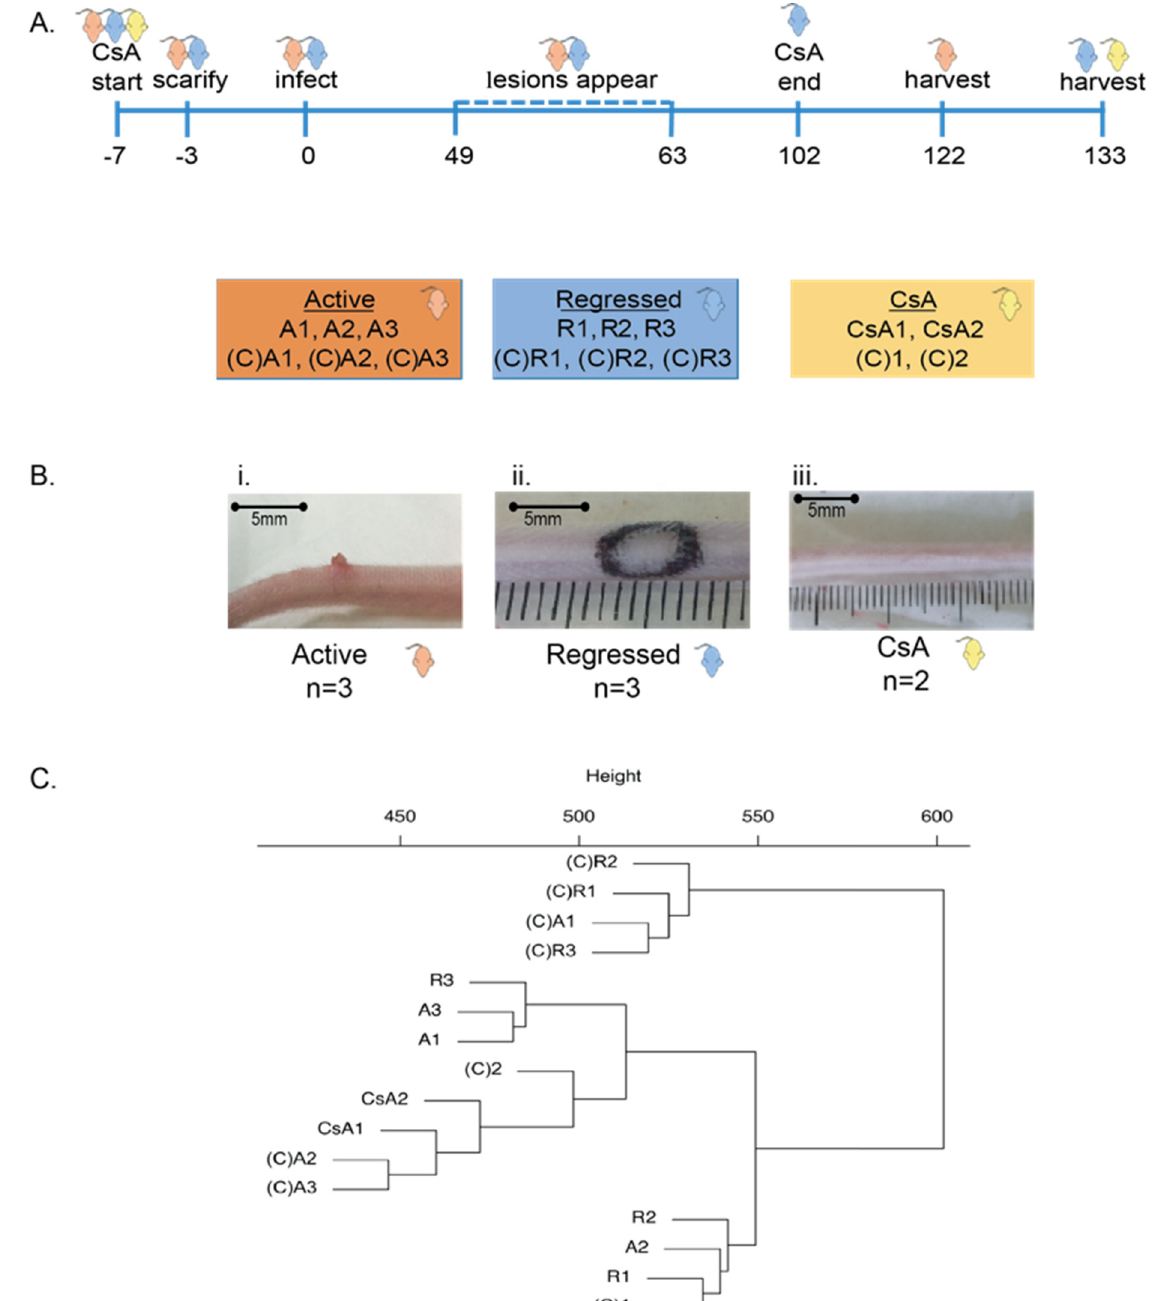
Figure 1. Experimental setup for the mouse model and preliminary methylation analysis. ( A ) Timeline of infection model. Colour-coded mouse images represent the three groups as shown in the boxes below. Boxes show sample names of each group and their associated control samples. ( B ) Representative images of the experimental groups show mouse tails at sample location; (i) Active viral infection, (ii) Regressed lesion (original lesion location delineated in black), (iii) CsA treated, uninfected. ( C ) Hierarchical clustering dendrogram showing the difference in total methylation of all high-coverage autosomal fragments for each of the 16 samples. A and R indicate actively MmuPV1 infected and MmuPV1 infected then regressed, respectively. (C)A and (C)R indicate mock infected and mock infected then regressed, respectively. CsA and (C) indicate CsA treated and untreated, respectively. Except for one sample, the largest difference in methylation is between four mice that were mock infected and three mice that were infected with MmuPV1.